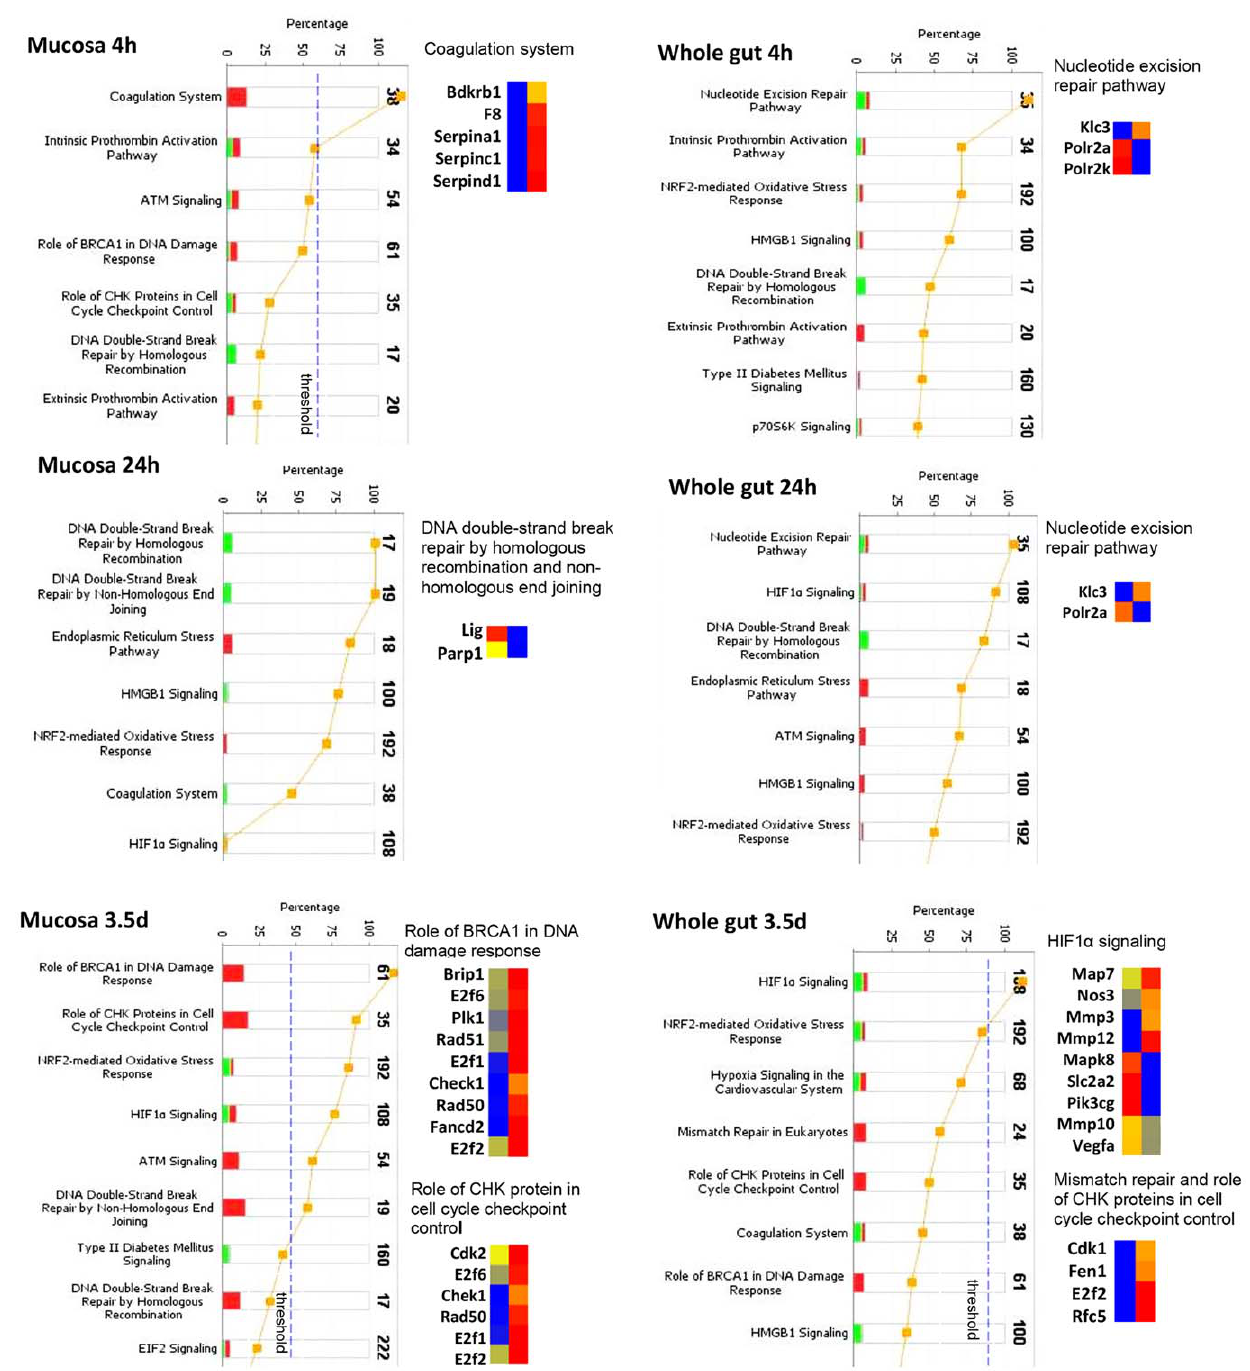
Figure 5. Activation of cellular injury and DNA damage repair pathways. Stacked bar charts demonstrate IPA-generated activated cellular injury and DNA damage repair pathways in mucosa and whole gut at 4 h, 24 h, and 3.5 d after irradiation. The height of the bars indicates the percentage of genes that changed in the particular pathway. Red bar: up-regulated. Green bar: down-regulated. Pathways with p-value (yellow dot) above the threshold (dashed line) are significantly activated. Heatmaps demonstrate the change of the genes in the selected signaling pathway before (left column) and after radiation (right column). Blue: decreased, red: increased.